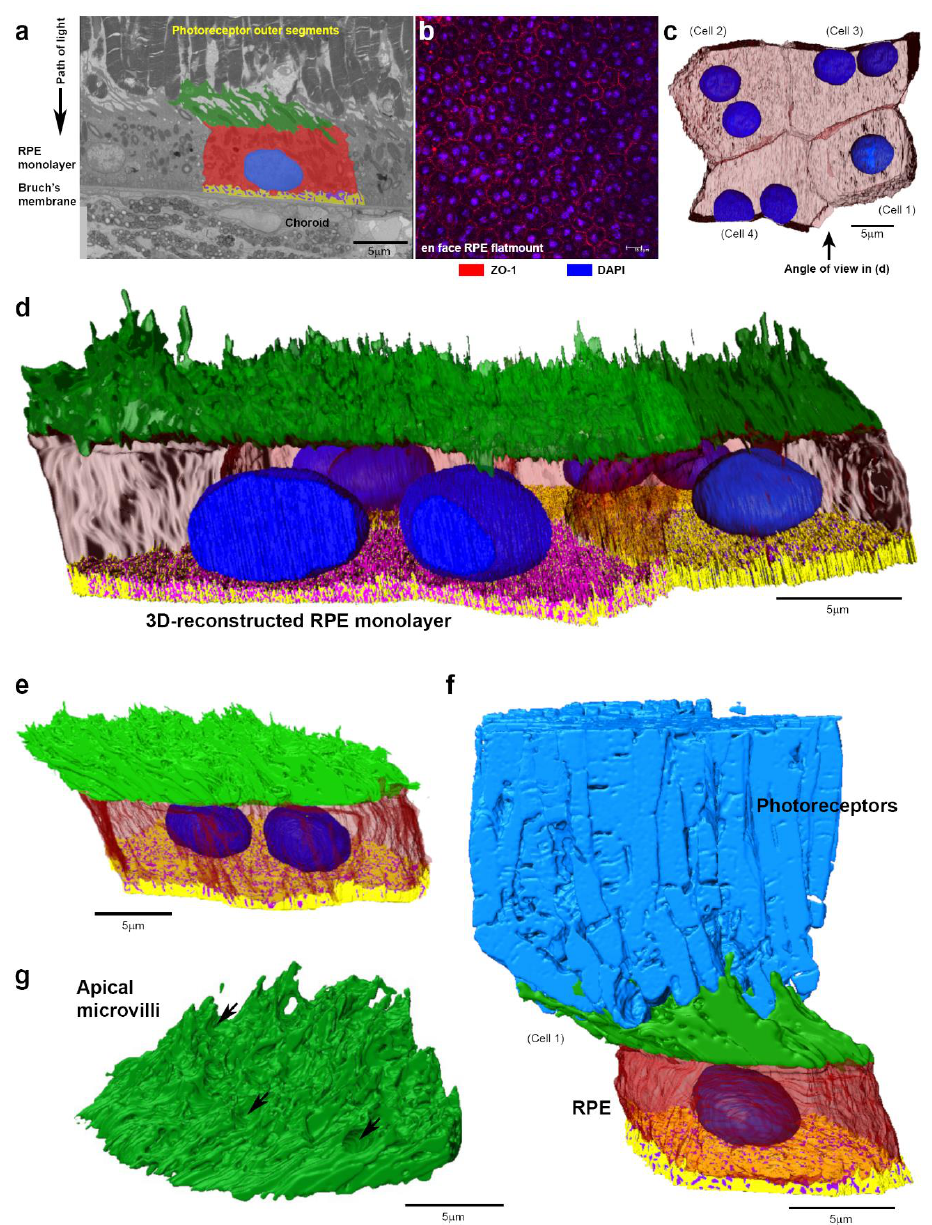
Figure 1. 3D architecture of the retinal pigment epithelium (RPE). ( a ) A single image from a serial block face scanning electron microscopy (SBF-SEM) stack showing arrangement of tissues in the outer retina with a segmented RPE cell in relation to overlying photoreceptors and the underlying Bruch’s membrane and choroid. ( b ) Confocal microscope image of representative RPE flatmount from the central mouse retina showing cobblestone cell morphology and predominantly bi-nucleate RPE. Scale bar = 15 µm. ( c ) Top–down view of an RPE patch reconstructed in 3D. Individual cells are assigned numbers, which correspond to the cell in ( f ) and in Figure S1c. (data sourced from one of three SBF-SEM stacks obtained from eyes of 3 different animals). ( d ) 3D RPE monolayer (observed from the angle indicated in ( c ) showing apical microvilli (green), nuclei (blue) with transparent cytoplasm allowing visualisation of the convoluted basolateral membrane (yellow) with sub-RPE spaces (purple). ( e ) Side view showing rhomboid RPE cell with unidirectionally organised apical microvilli that interface with outer segments (OS) at the same angle. ( f ) 3D arrangement of photoreceptors in relation to the RPE. ( g ) Unidirectionally organised microvilli on the apical RPE surface and footprints (arrows) where photoreceptor OS terminate. Unless stated otherwise, scale bars = 5 µ